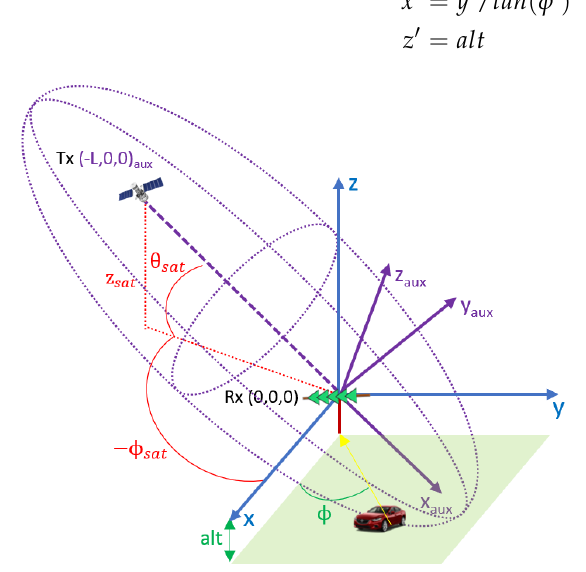
Figure 6. PR geometry: local Cartesian space (blue), auxiliary coordinate system